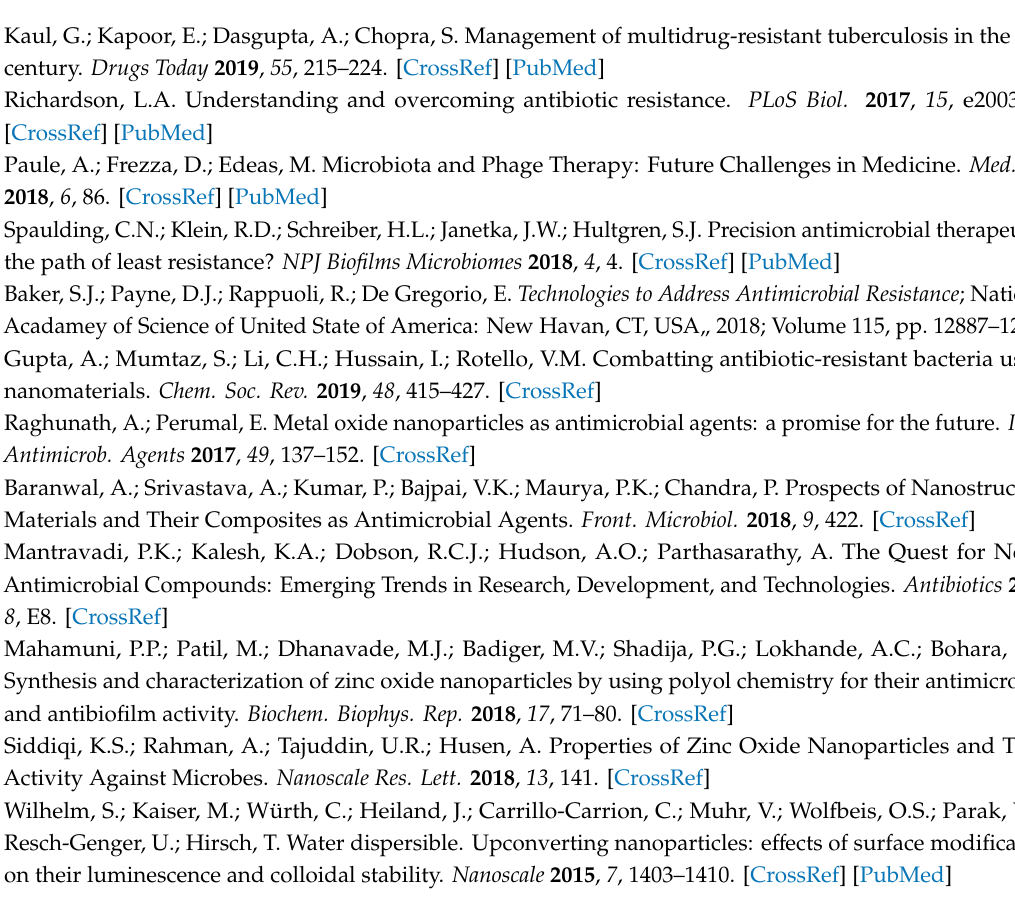
Figure S1. FTIR of Fragmented Lignin, Figure S2. 1H-NMR of Fragmented Lignin, Figure S3. HRMS of Fragmented